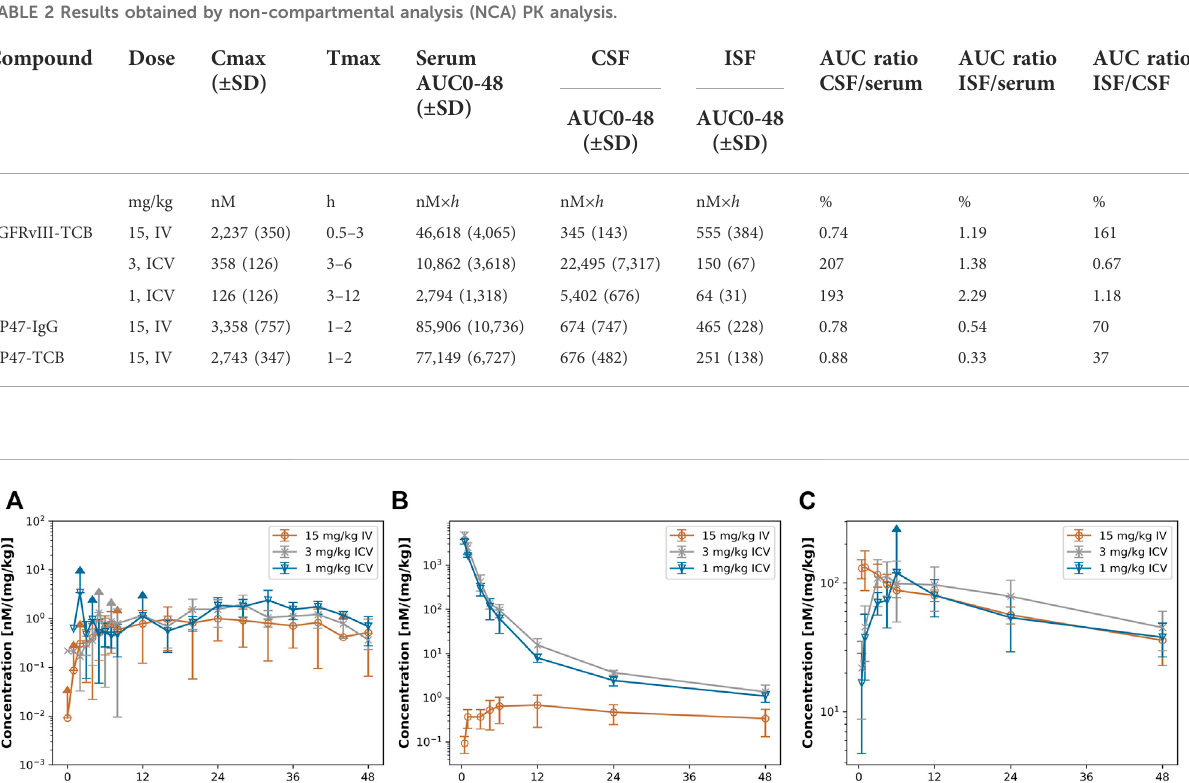
TABLE 2 Results obtained by non-compartmental analysis (NCA) PK analysis.